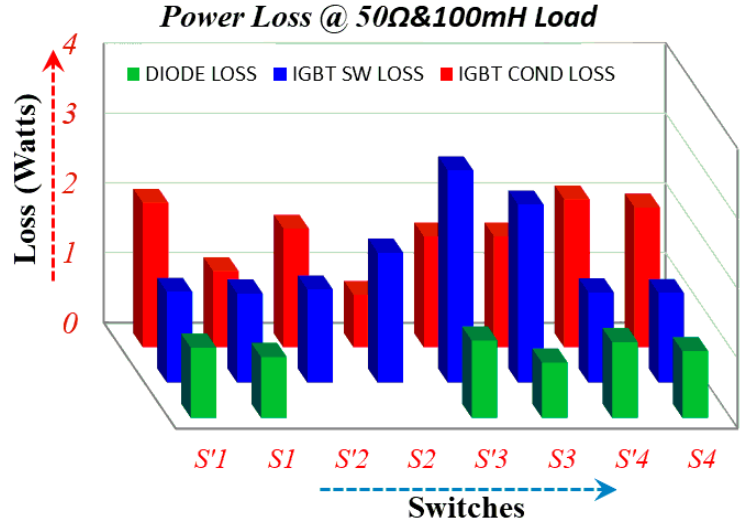
Figure 10. Simulation value of power loss calculation of switches.